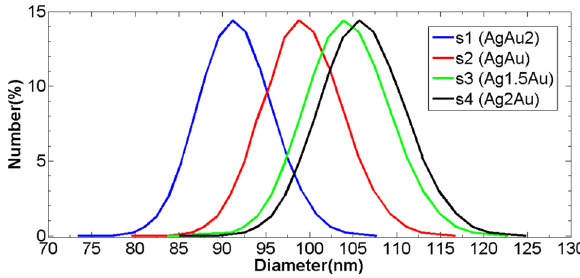
Fig. 11 The size of NPs obtained from DLS